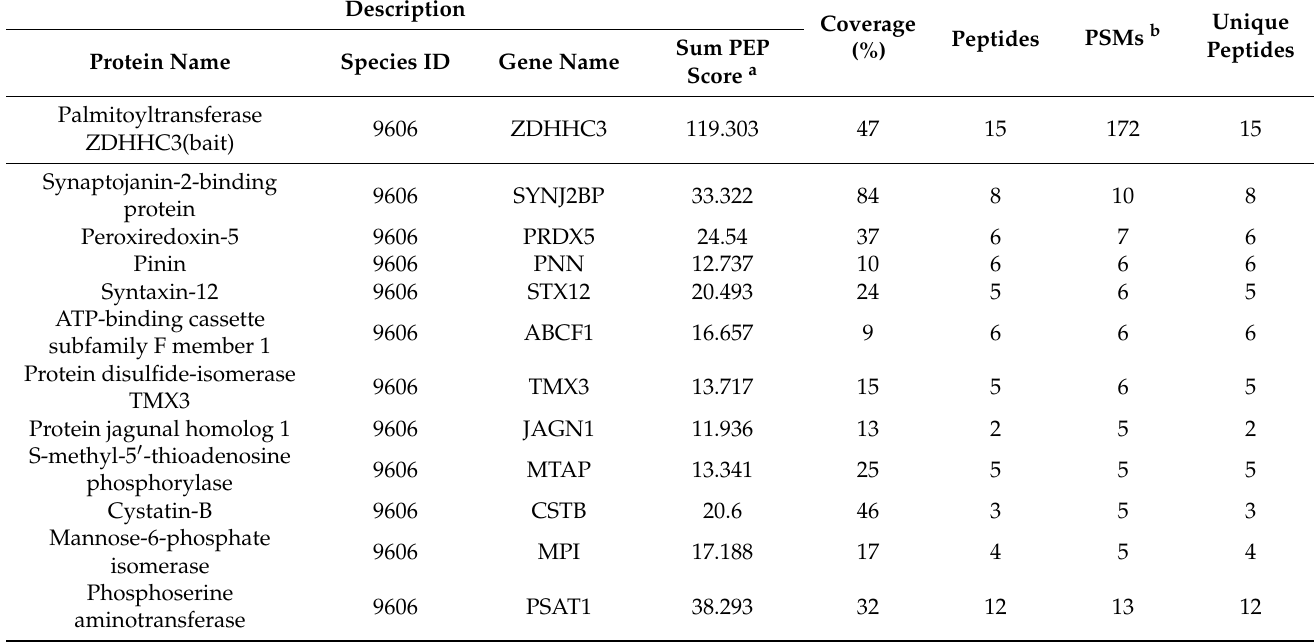
Table 1. Proteins identified by the pull-down assay combined with LC-MS/MS